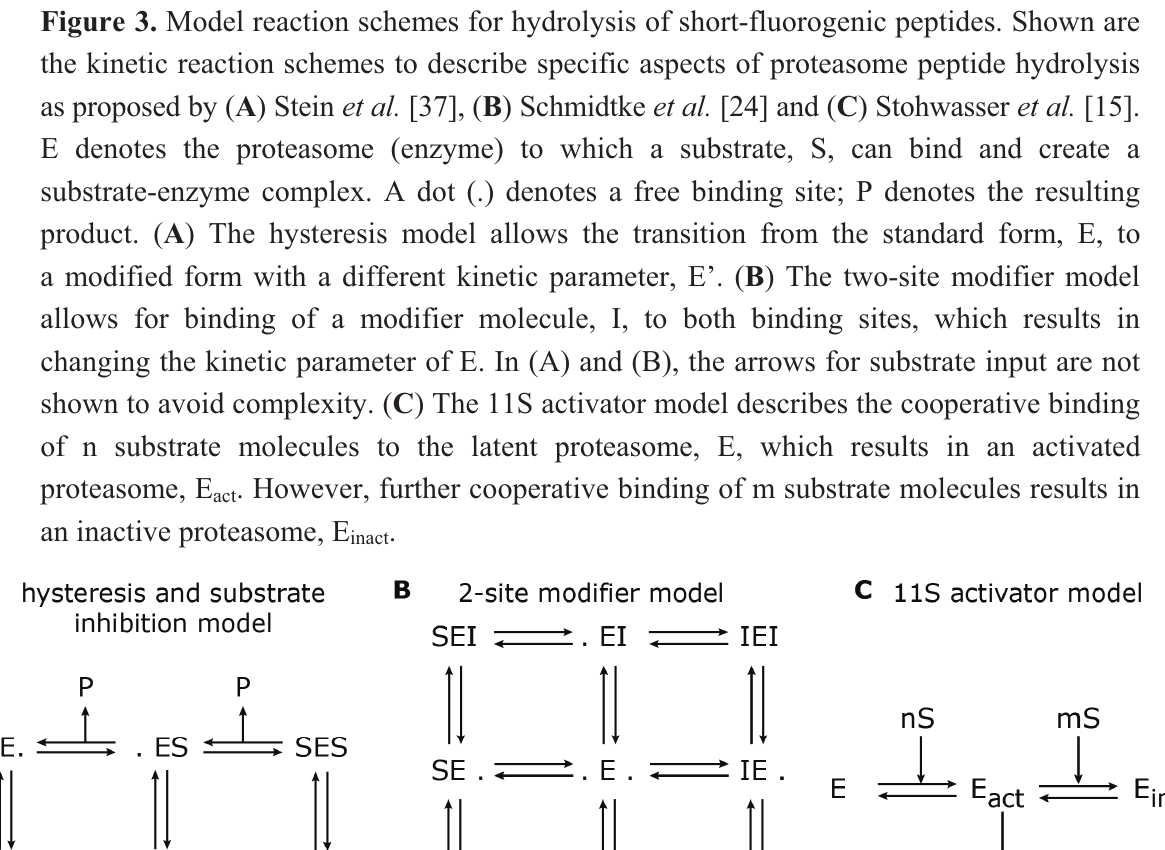
Figure 3. Model reaction schemes for hydrolysis of short-fluorogenic peptides. Shown